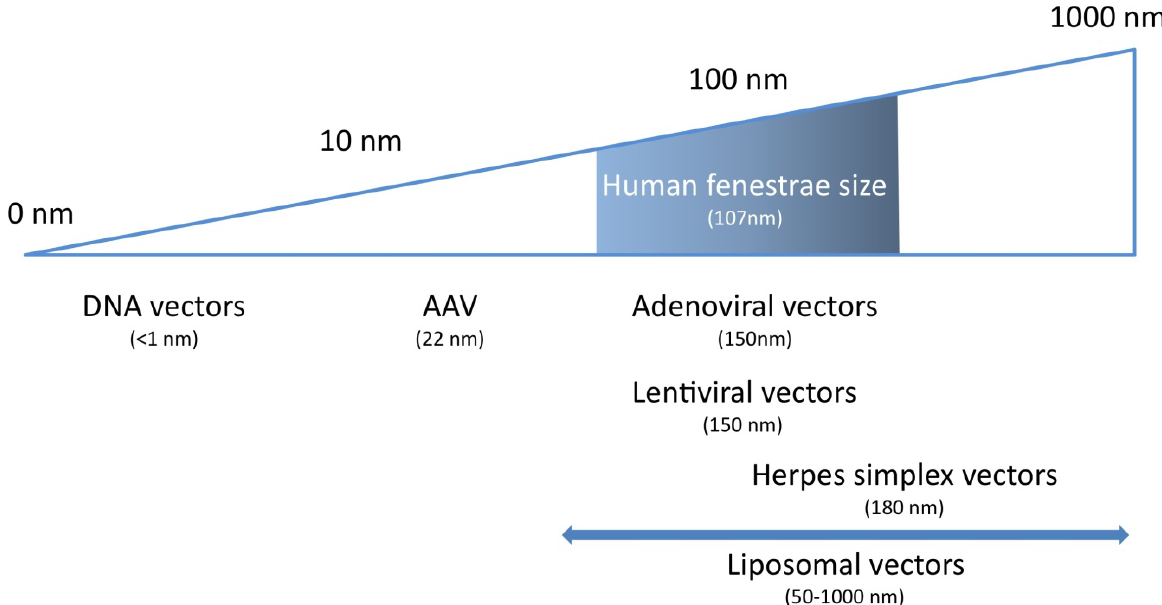
Figure 1. Relevance of gene therapy vector dimensions for gene transfer efficiency into hepatocytes. Human liver sinusoidal fenestrae show a Gaussian size distribution (shaded box) and have an average diameter of 107 nm. To ensure efficient transendothelial passage of gene transfer vectors, their size should be small enough to pass through the fenestrae into the space of Disse. The only gene therapy systems that display this highly desirable feature are naked DNA transfer and AAV-mediated